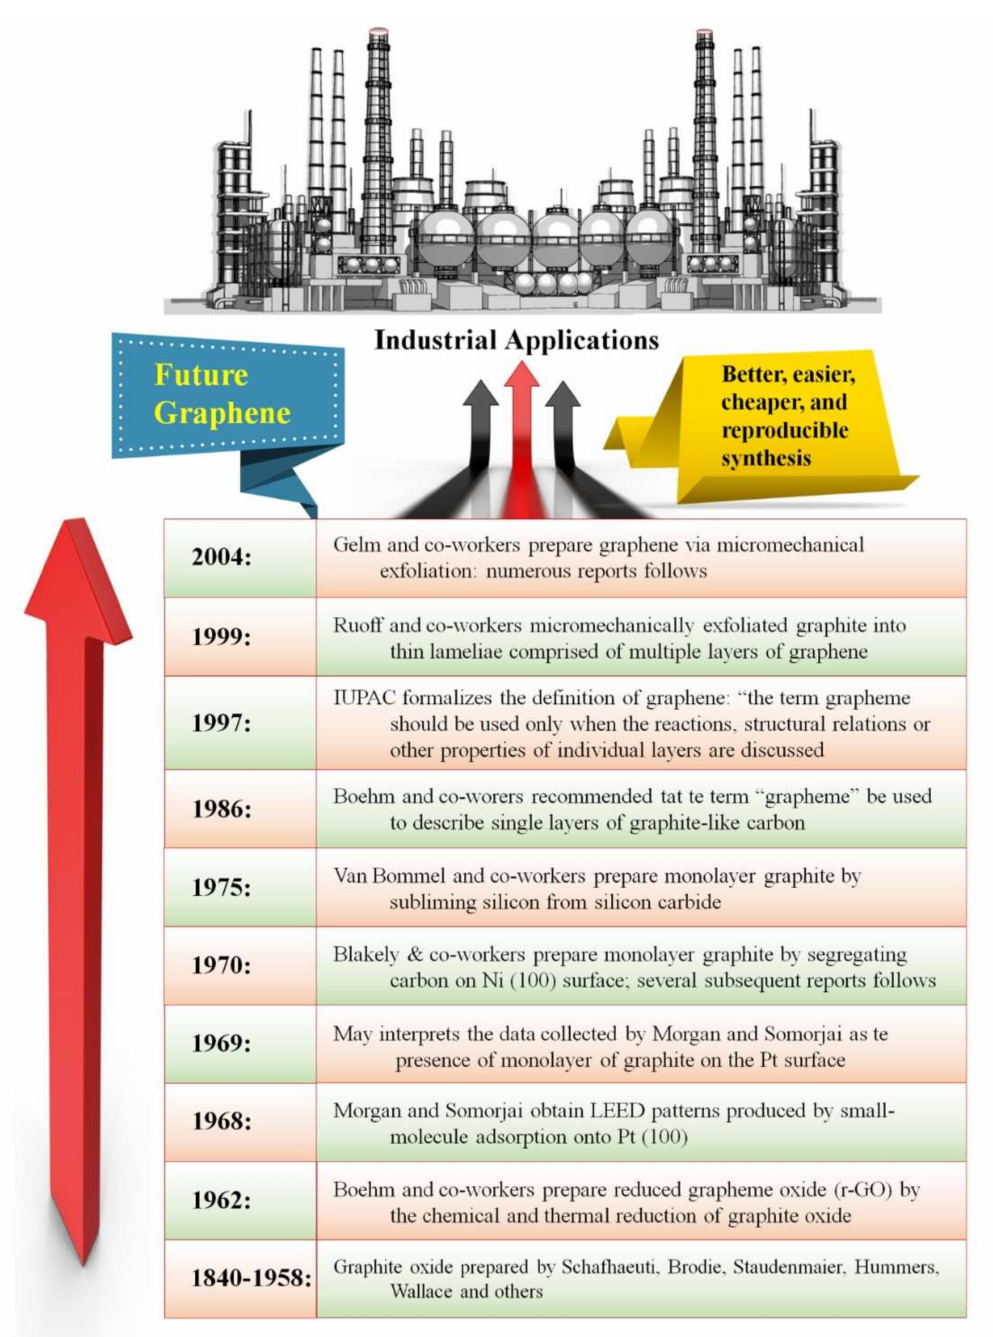
Figure 3. Roadmap representing the development and future of graphene reproduced from Ref.